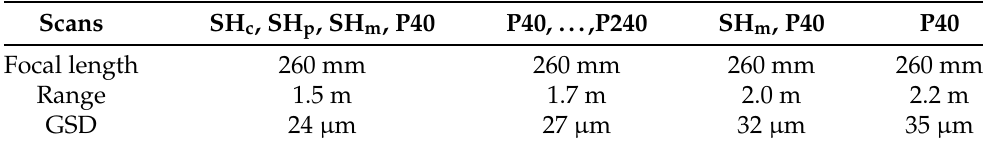
Table 2. Summary of the range and focal length used for sample scans and the corresponding GSD at the sample. P## = sandpaper artifact of grit P##, SH = step-height artifact, c = clean, p = projected light pattern, m = marked pattern.